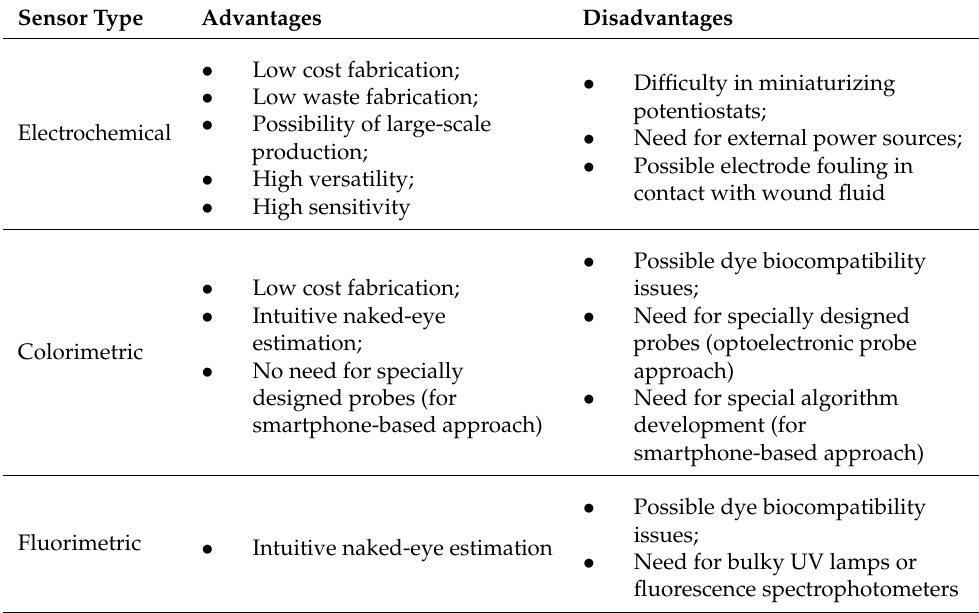
Table 2. Advantages and disadvantages of different types of wearable sensors for wound infection biomarker